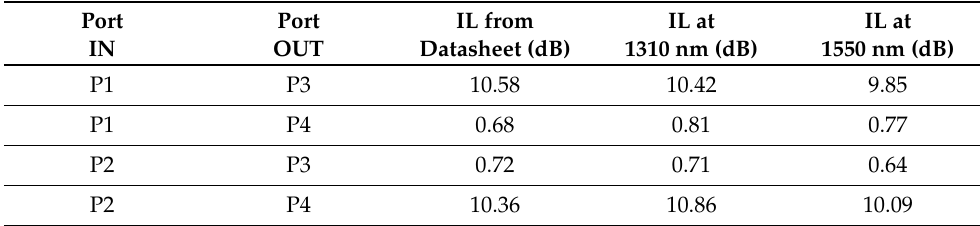
Table 5. Insertion loss of the coupler 90:10 measured with OTDR